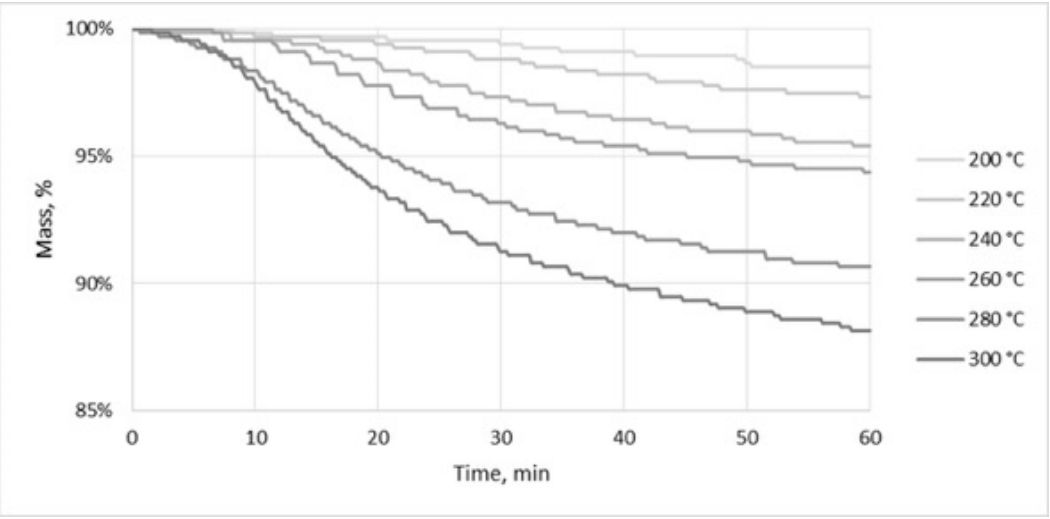
Figure 12. TGA of digestate at torrefaction temperatures.